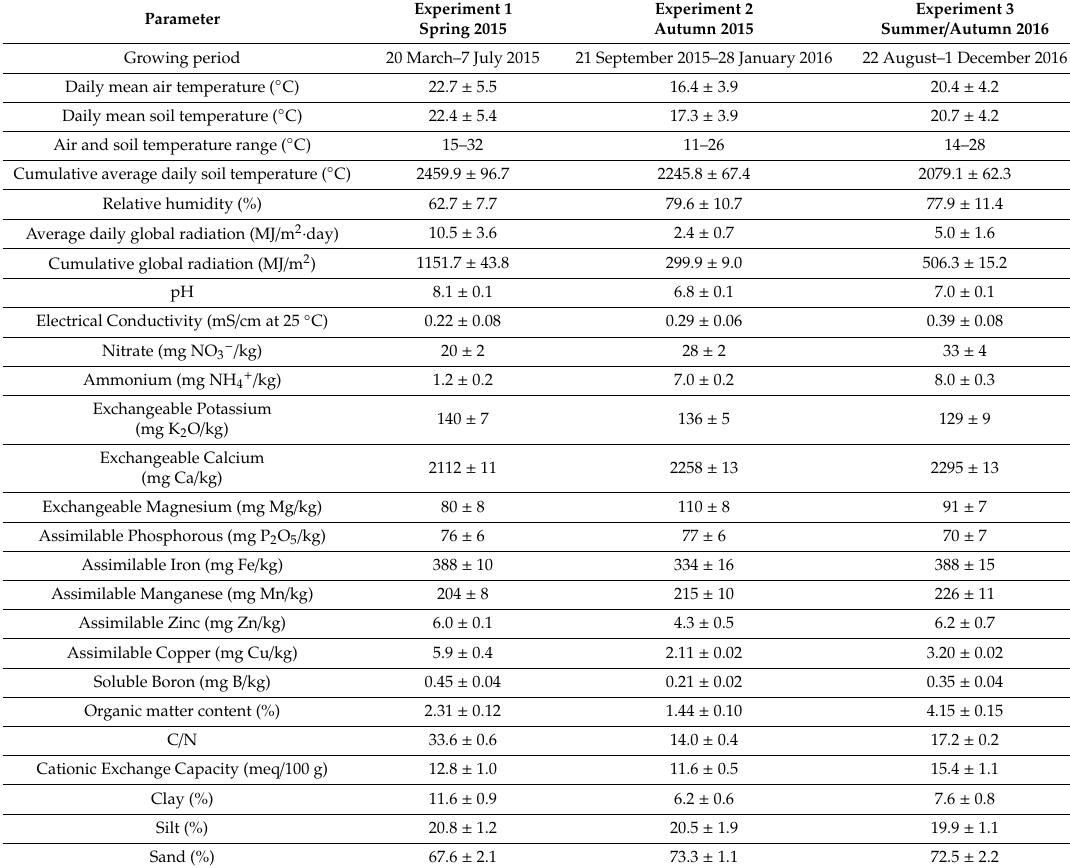
Table 2. Climate and soil parameters measured in the three experiments. Temperature, humidity and radiation are reported as the average values inside the greenhouse during the whole experimental period. Soil parameters are reported as the initial values immediately before the beginning of each